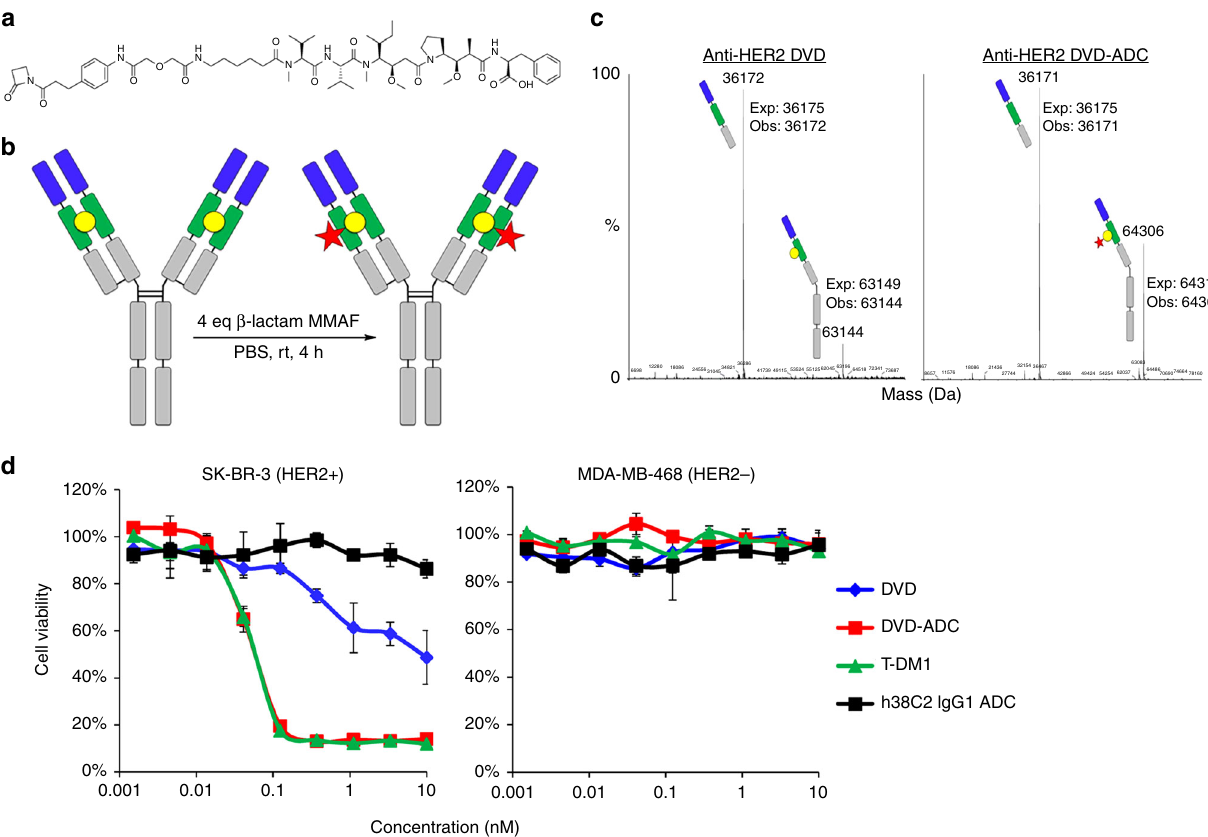
Fig. 2 Assembly of DVD-ADCs and in vitro ef fi cacy. a Structure of β -lactam MMAF. b anti-HER2 DVD-ADC was assembled by incubating the anti-HER2 DVD with four equivalents (eq) of β -lactam MMAF at room temperature (rt) for 4 h. Drug attachment (red star) occurs at the reactive Lys of h38C2 (yellow circle), located in the heavy chain variable domain of anti-HER2 DVD, to form a stable amide bond. c ESI-MS was performed with unconjugated anti-HER2 DVD and conjugated anti-HER2 DVD-ADC after reduction (10 mM DTT) and deglycosylation (PNGase F). No conjugation was detected on the light chain and the increase in mass of the heavy chain (~1160 Da) corresponds to the addition of exactly one eq of β -lactam MMAF. No unconjugated or higher drug loaded species were detected. d Cytotoxicity of anti-HER2 DVD-ADC (red) following incubation with HER2+ BC cell line SK-BR-3 and HER2 − BC cell line MDA-MB-468 for 72 h at 37 °C (mean ± SD of triplicates). Unconjugated anti-HER2 DVD (blue) was signi fi cantly less toxic to SK-BR-3 cells when compared to anti-HER2 DVD-ADC ( p < 0.0001; extra sum-of-squares F -test). T-DM1 (green) was used as a positive control and h38C2 IgG1 ADC (black, h38C2 IgG1 conjugated to β -lactam MMAF) as a negative